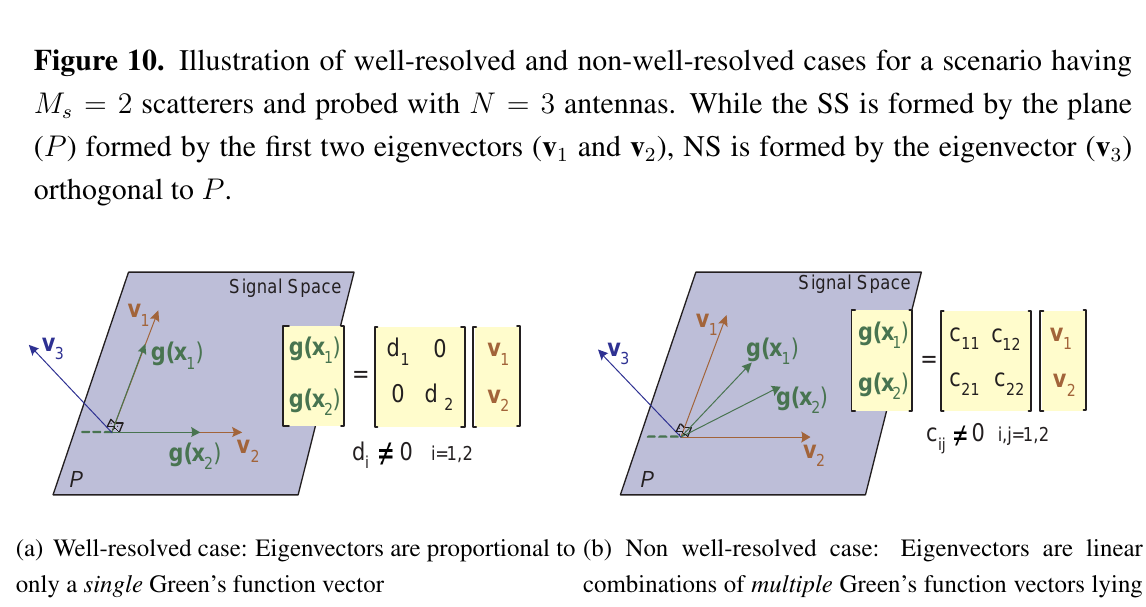
and v ), NS is formed by the eigenvector ( v 1 2